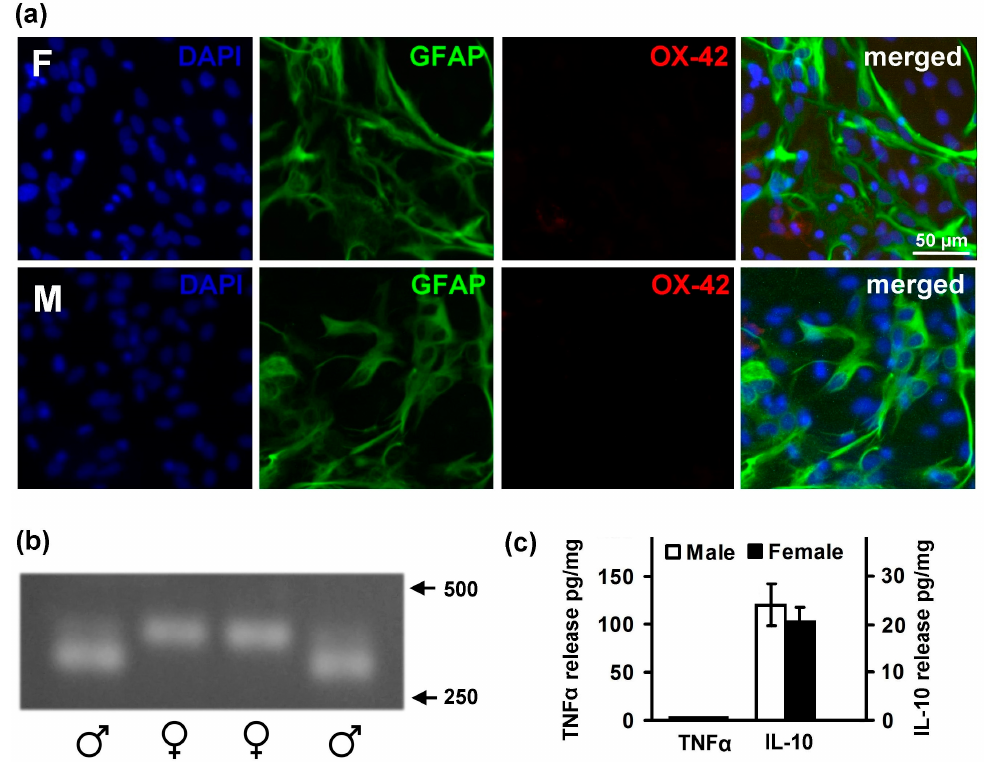
Figure 1. Comparison of astrocyte cultures obtained from male and female rats. ( a ) Representative immunofluorescence images showing female (F) and male (M) astrocytes cell culture morphology and purity. The cultures were fixed with 3% paraformaldehyde and incubated with DAPI (4 ′ ,6-diamidino-2-phenylindole, blue), OX-42 (Anti-CD11b/c antibody OX-42, red), and GFAP (glial fibrillary acidic protein, green). The last panels are the merged images; ( b ) An example of agarose (2%) electrophoresis of PCR products. Samples obtained from male tails have two products (margin lanes), and from the female tails—one product (central lanes). All of the products have length between 250 and 500 bp. The molecular weight marker ladder is not shown; ( c ) Comparison of basal levels of released mediators. TNF α (left scale) and IL-10 (right scale) concentrations were measured by ELISA in supernatant samples of male (white bars) and female (black bars). Values represent mean ± SEM from three independent experiments performed in